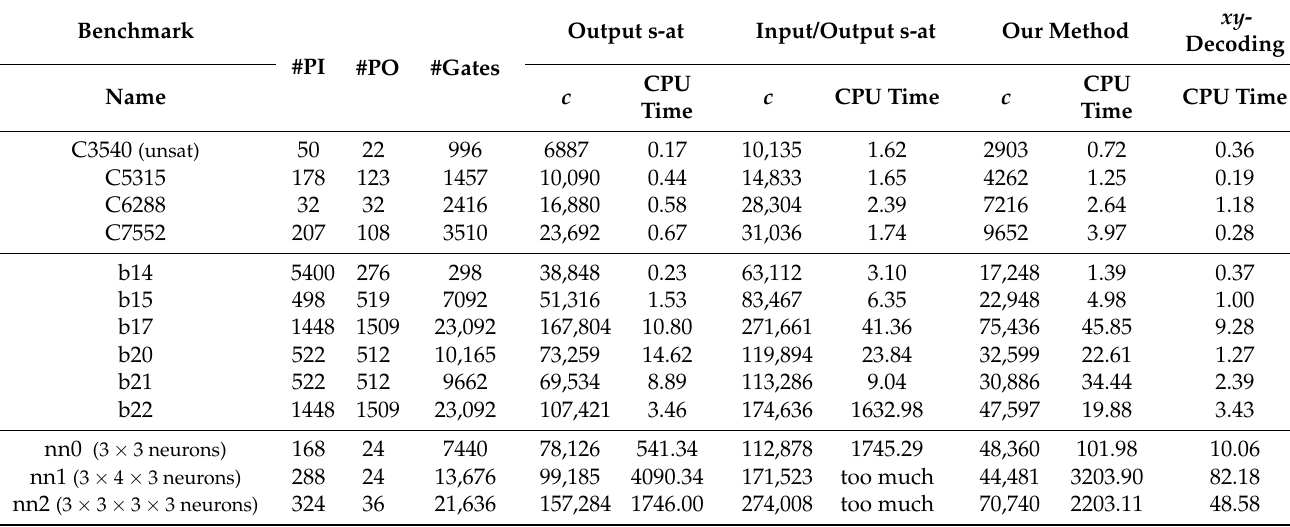
Table 1. Characteristics of the considered benchmarks and performance of SAT-based reasoning on multiple faults for the three methods considered in this work. Data have been collected for A max = 2 and E min = 20; c is the number of clauses and CPU times are in